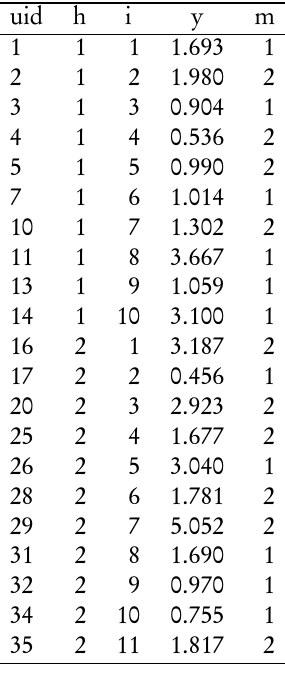
First frame extracted from the toy